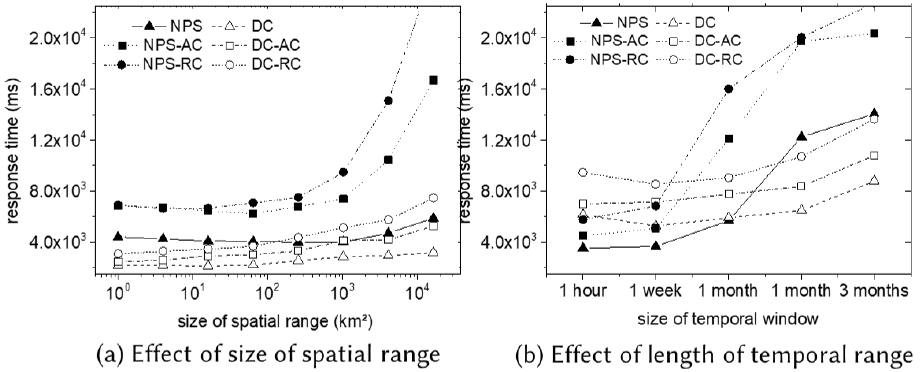
Figure 15. Experimental results in a real